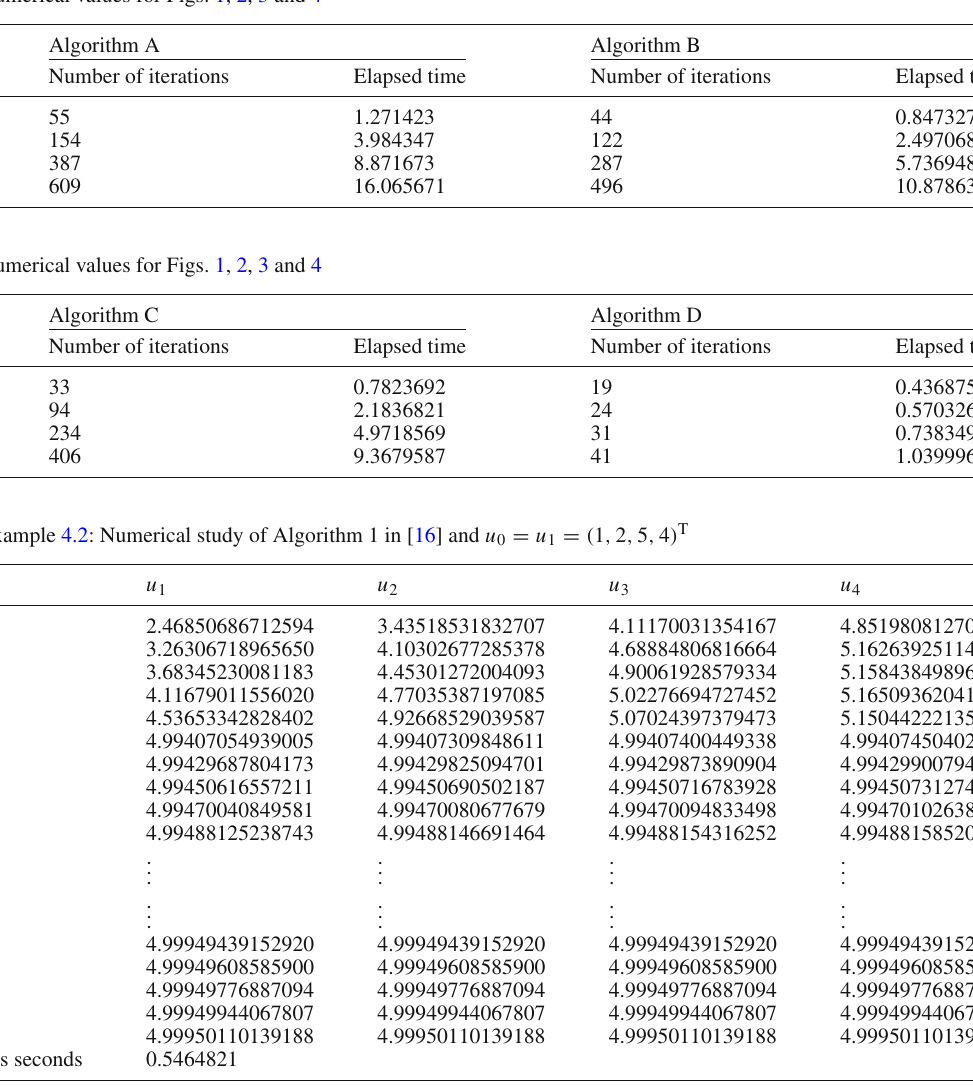
Table 1 Numerical values for Figs. 1, 2, 3 and 4